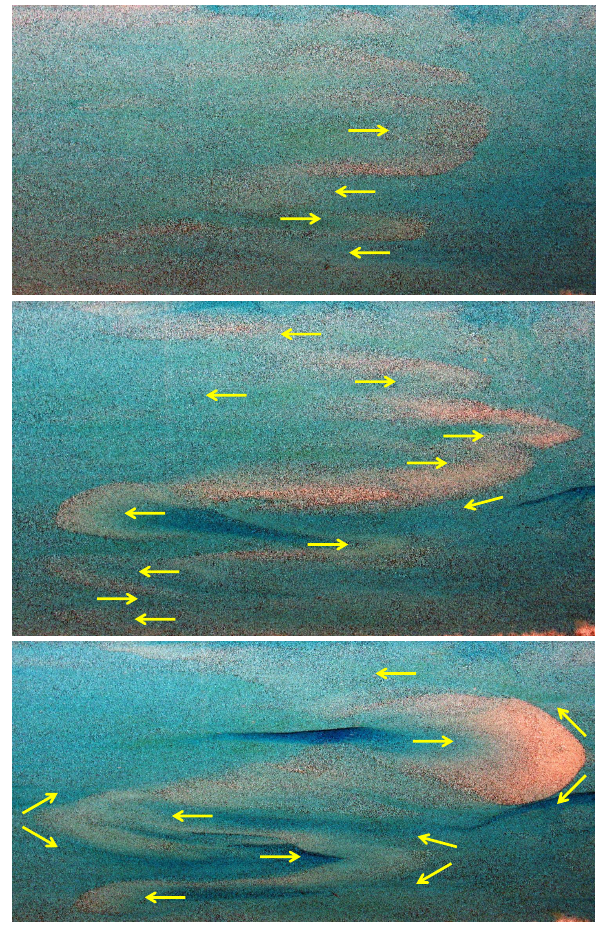
Fig. 4. Top view on transitional V-shaped to diamond-shaped tidal bars in moderate-energy experiment 3 after about 200, 1000 and 2000